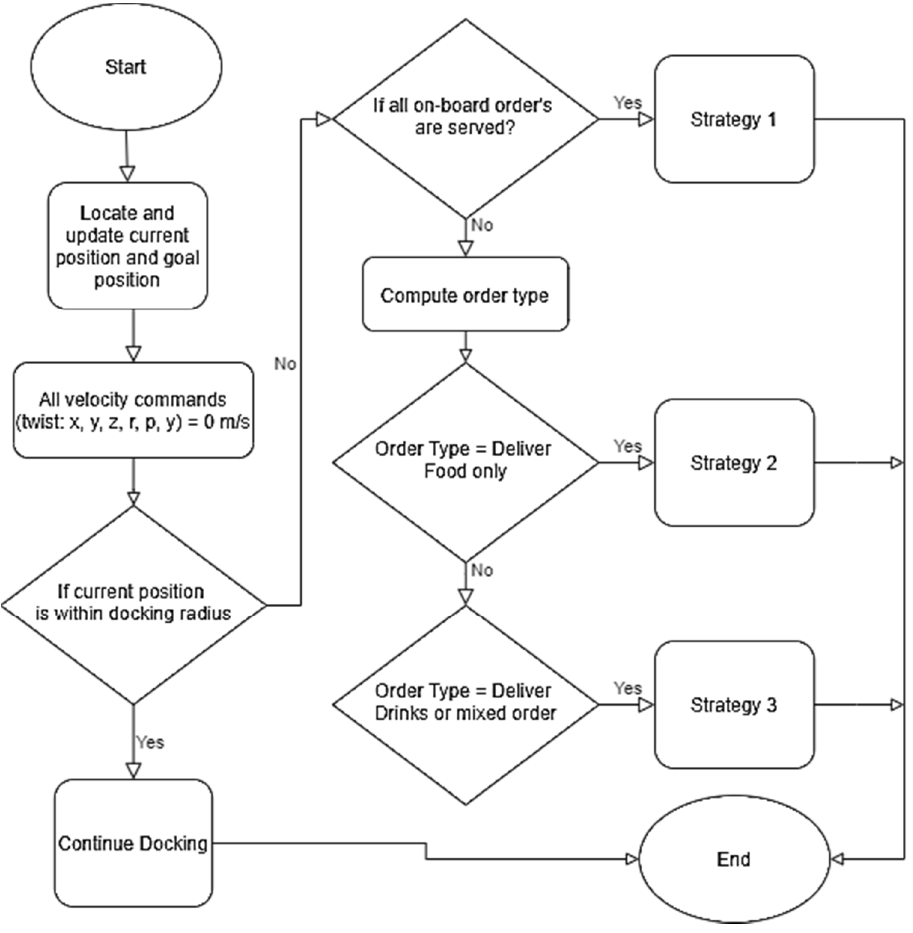
Figure 8. Dock state algorithm.